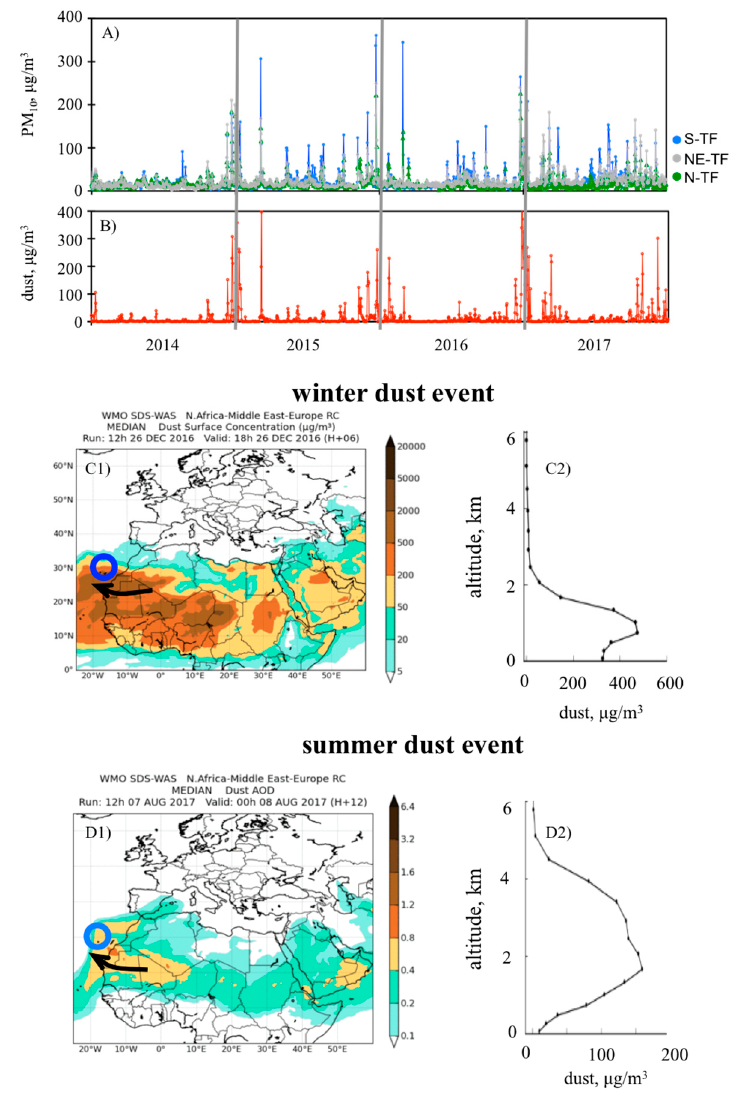
Figure 2. Time series of daily mean values of ( A ) PM 10 measured at three sites of Tenerife (South, S-TF; Northeast, NE-TF; and North, N-TF) and of ( B ) surface dust concentrations provided by the World Meteorological Organization’s Sand and Dust Storm Warning Advisory and Assessment System (WMO SDSWAS). Example of a typical dust event of winter (26-Dec-2016): surface dust concentrations ( C1 ) and vertical dust profile in Tenerife ( C2 ). Example of a typical dust event of summer (08-Aug-2017): dust optical depth ( D1 ) and vertical dust profile in Tenerife ( D2 ). Blue circle highlights the location of